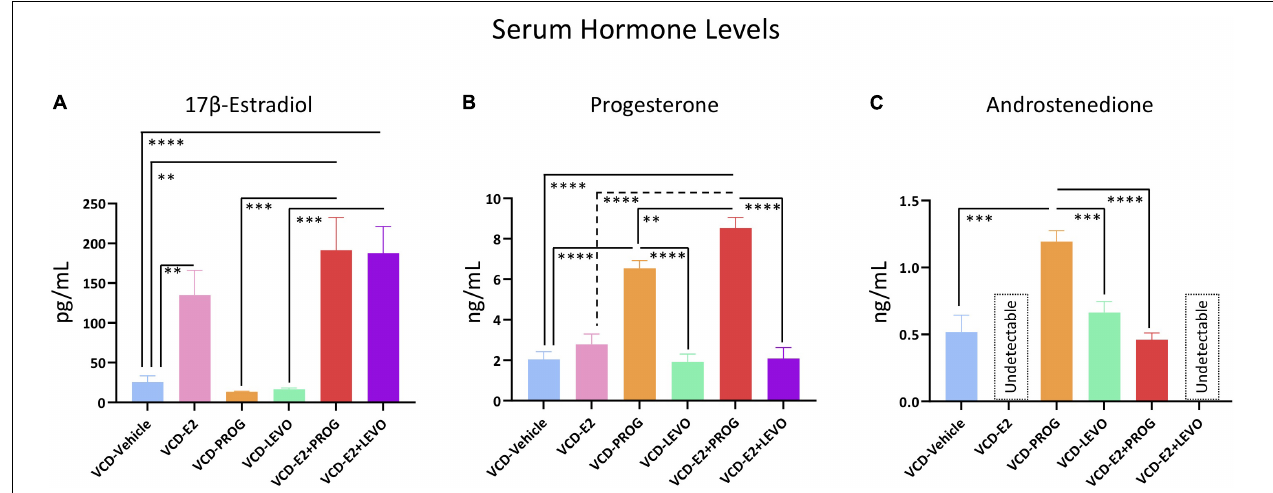
FIGURE 12 | Serum Hormone Levels. (A) E2 was elevated in VCD-E2, VCD-E2 + PROG, and VCD-E2 + LEVO groups compared to VCD-Vehicle rats. Additionally, combination hormone therapy groups had elevated E2 compared to their respective progestogen-only groups. E2 analysis n/group: VCD-Vehicle n = 9; VCD-E2 n = 10; VCD-PROG n = 9; VCD-LEVO n = 9; VCD-E2 + PROG n = 10; VCD-E2 + LEVO n = 10. (B) Progesterone was elevated in the VCD-PROG group and the VCD-E2 + PROG group compared to the VCD-Vehicle group, VCD-E2 group, and VCD-LEVO group. The combination hormone group had higher progesterone levels compared to the VCD-PROG group alone. Progesterone analysis n/group: VCD-Vehicle n = 10; VCD-E2 n = 10; VCD-PROG n = 9; VCD-LEVO n = 9; VCD-E2 + PROG n = 10; VCD-E2 + LEVO n = 10. (C) All subjects in the VCD-E2 group and VCD-E2 + LEVO group had undetectable levels of androstenedione. Androstenedione was elevated in the VCD-PROG group compared to VCD-Vehicle, VCD-LEVO, and VCD-E2 + PROG groups. Androstenedione analysis n/group: VCD-Vehicle n = 9; VCD-E2 n = 0 [undetectable]; VCD-PROG n = 9; VCD-LEVO n = 9; VCD-E2 + PROG n = 10; VCD-E2 + LEVO n = 0 [undetectable].